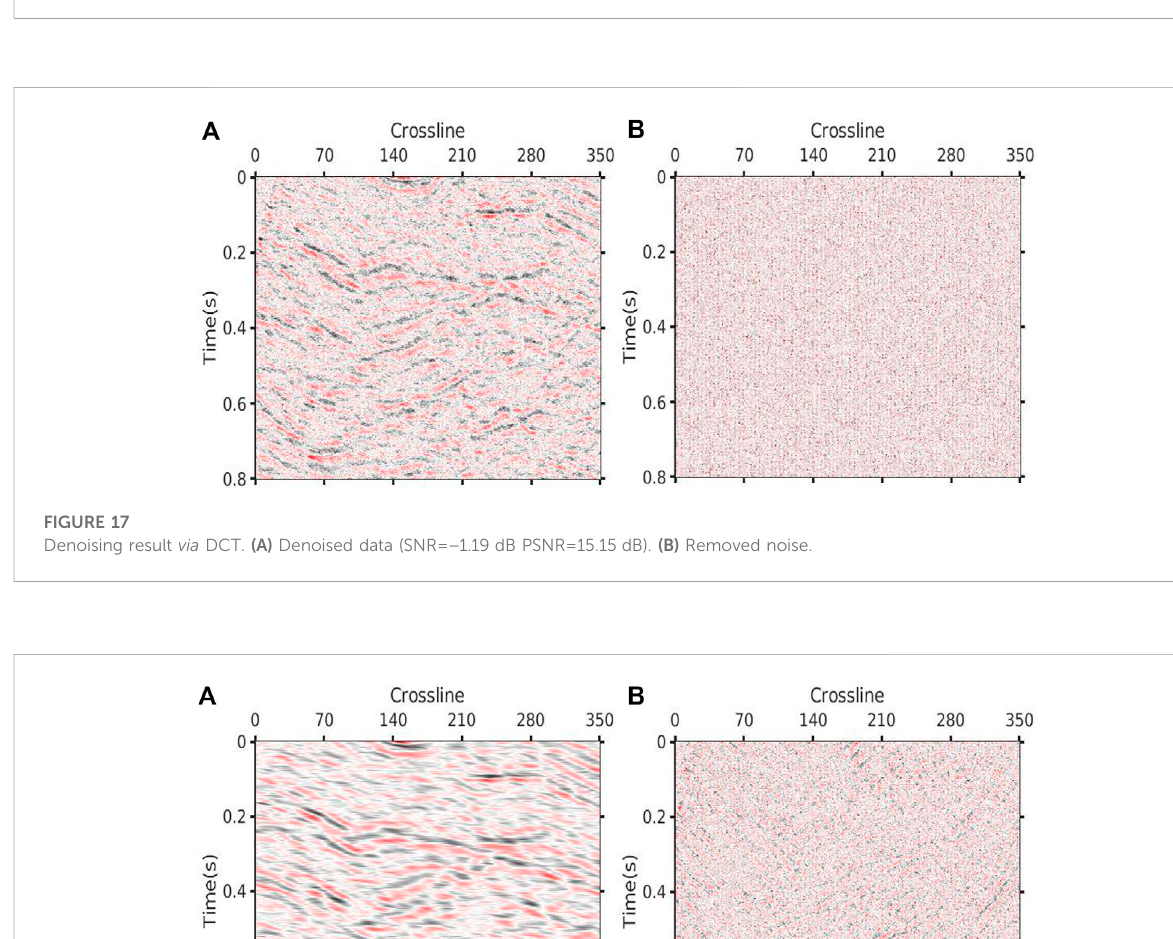
Frontiers in Earth